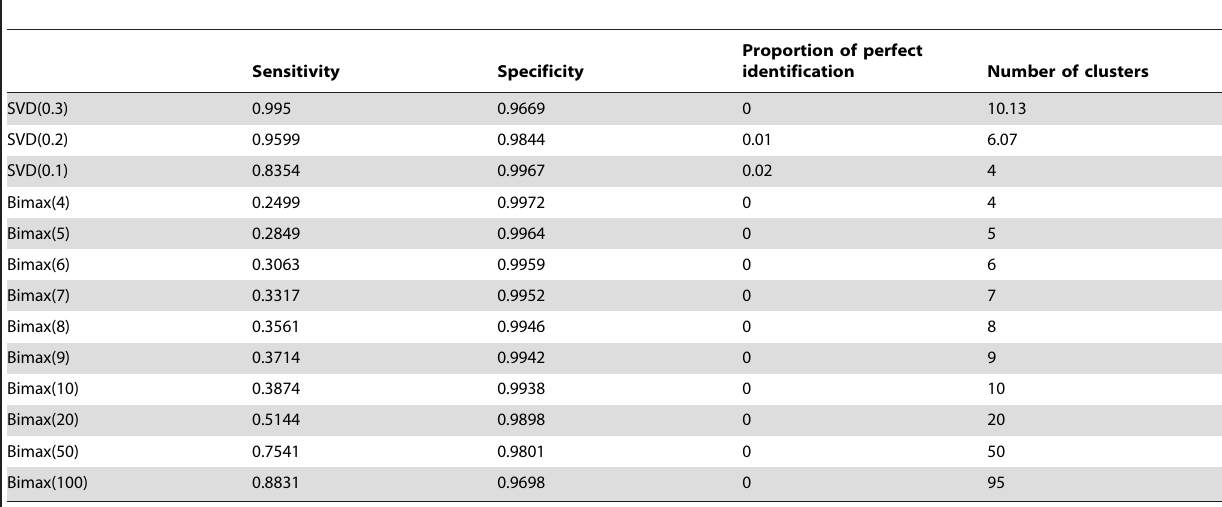
Table 2. Performance of SVD( d ) and Bimax( k ) on a binary synthetic dataset, where d is the tolerance threshold and k is the number of clusters. The results are the average over 100 simulated